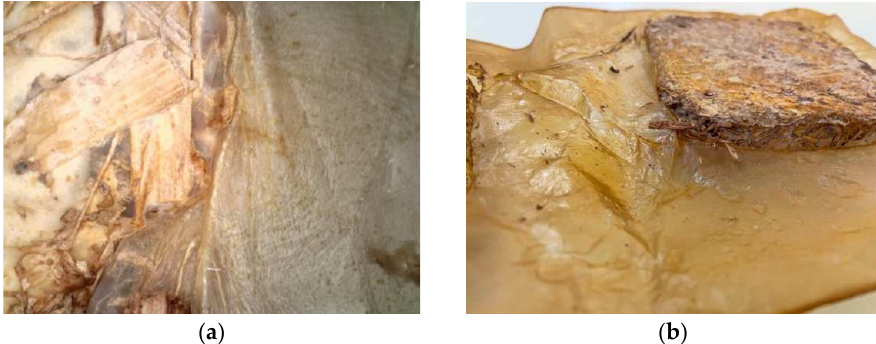
Figure 5. ( a ) Dried BC around oven-dried mycelium tile under the Dino-Lite digital microscope. ( b ) Large BC sheet dried around mycelium tile (image credit: authors).